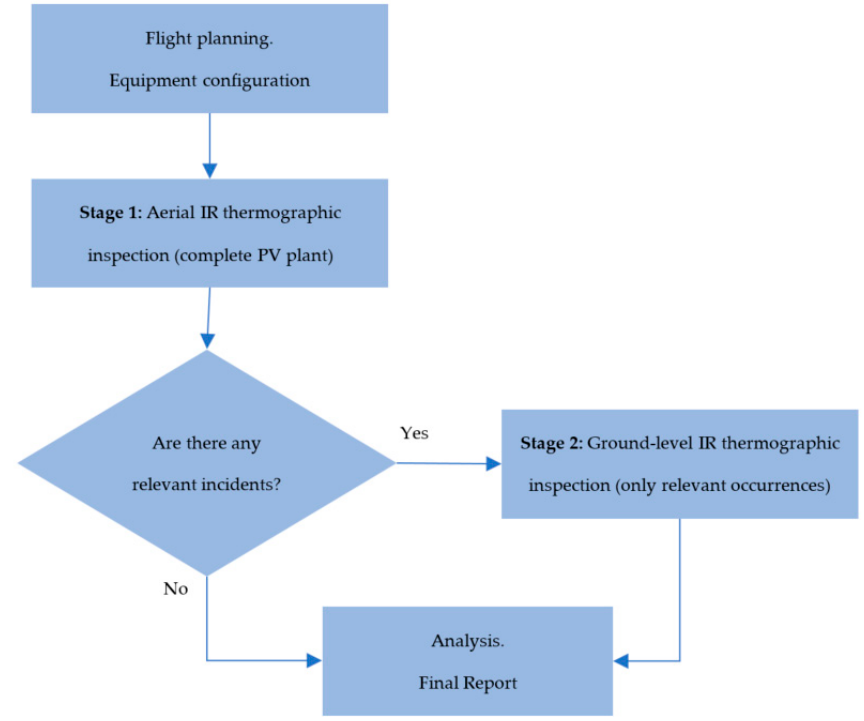
Figure 2. Flowchart for two-stage strategy.